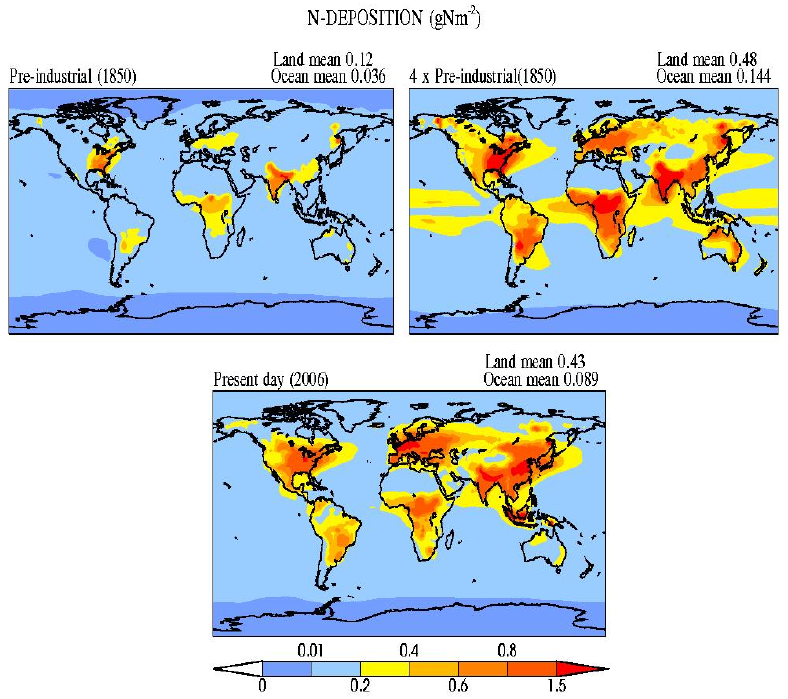
Fig. 1. Spatial distribution of N deposition in the pre-industrial period (1850; top left panel), four times the pre-industrial N deposition case (4N; top right panel) and present-day (2006; bottom panel) in the input data sets of CLM4. The global mean pre-industrial N deposition over land is 0.12gNm − 2 (a total land deposition of 20.3TgNyr − 1 ) . The deposition in the experiment 4N (80.6TgNyr − 1 ) is approximately close to the present-day deposition of 0.43gNm − 2 ( ∼ 73.1TgNyr − 1 ) . We infer from this figure that the spatial pattern of N deposition used in our experiments is similar to present-day